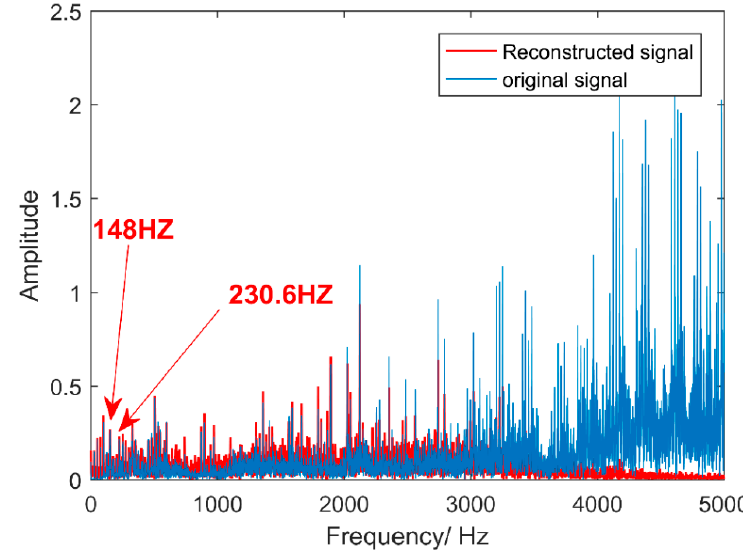
Figure 18. Vibration signal reconstruction.